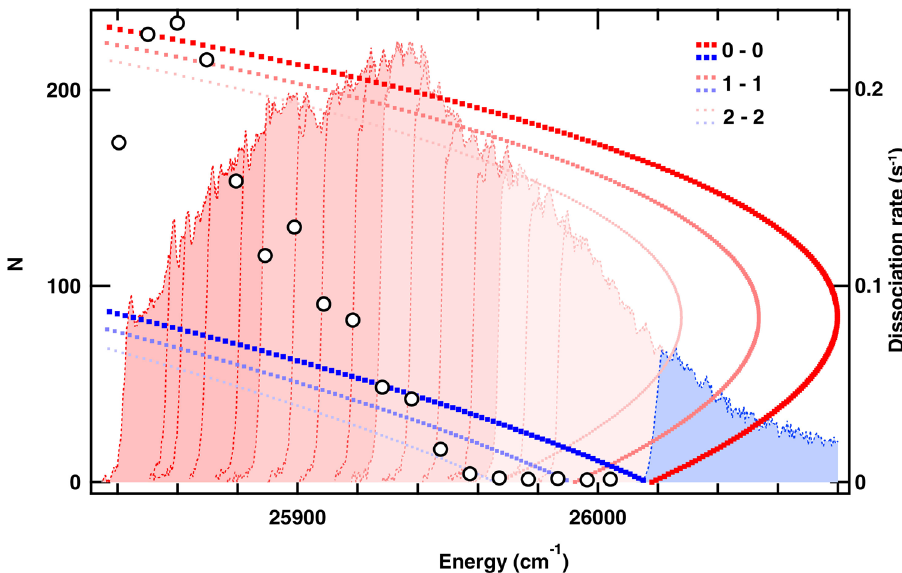
Fig. 4 N > 160 two-step preparation and dissociation measurements. The blue spectral area was exposed in Step 1, pink and red-shaded areas are added serially in Step 2. Blue and red dots, associated with the left-hand y-axis, are Fortrat parabolas of 0-0, 1-1 and 2-2 vibrational bands of the B-X transition. Open circles, associated with the right-hand y-axis, show the dissociation rates corresponding to the various Step 2 optical pumping spectra.